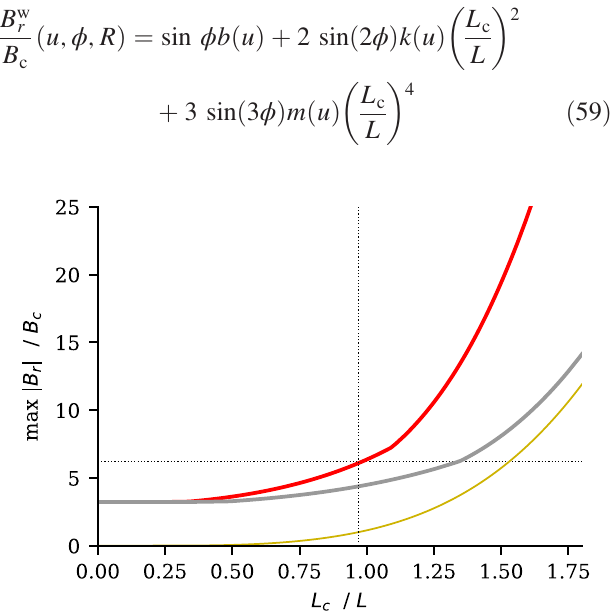
FIG. 13. Maximum weighted pole-tip field B w r (red), actual pole-tip field B pt r (gray), and pole-tip field of sextupole compo- nent (yellow) in dependence of normalized inverse cell length L =L , all in units of characteristic field density and length. The c values of max j B r j ¼ 2 T for SLS 2.0 assumptions and the =L for a maximum weighted pole- corresponding value of L c tip field close to that strength are denoted by dotted